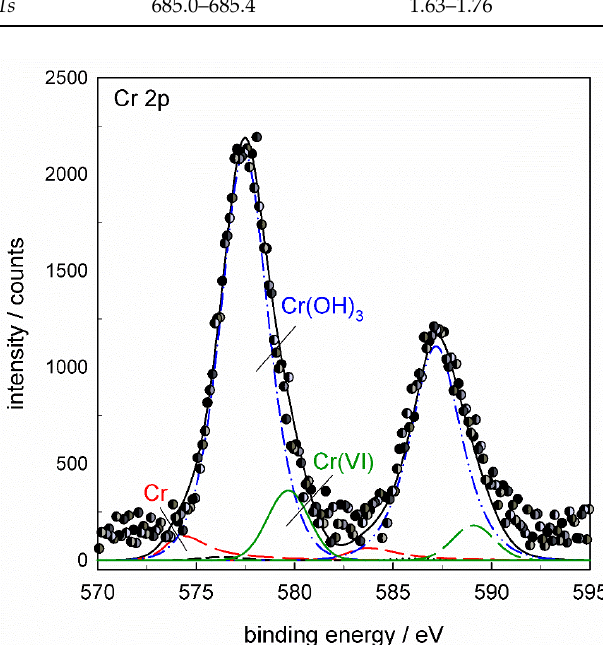
Figure A7. An example is given for the Cr 2p spectrum deconvoluted using four component peaks: Cr, Cr 2 O 3 , Cr(OH) 3 and Cr(VI) (without CrF 3 ). Component peak related to Cr(VI) species dropped to zero when using component peak for CrF 3 (Figure 17a).